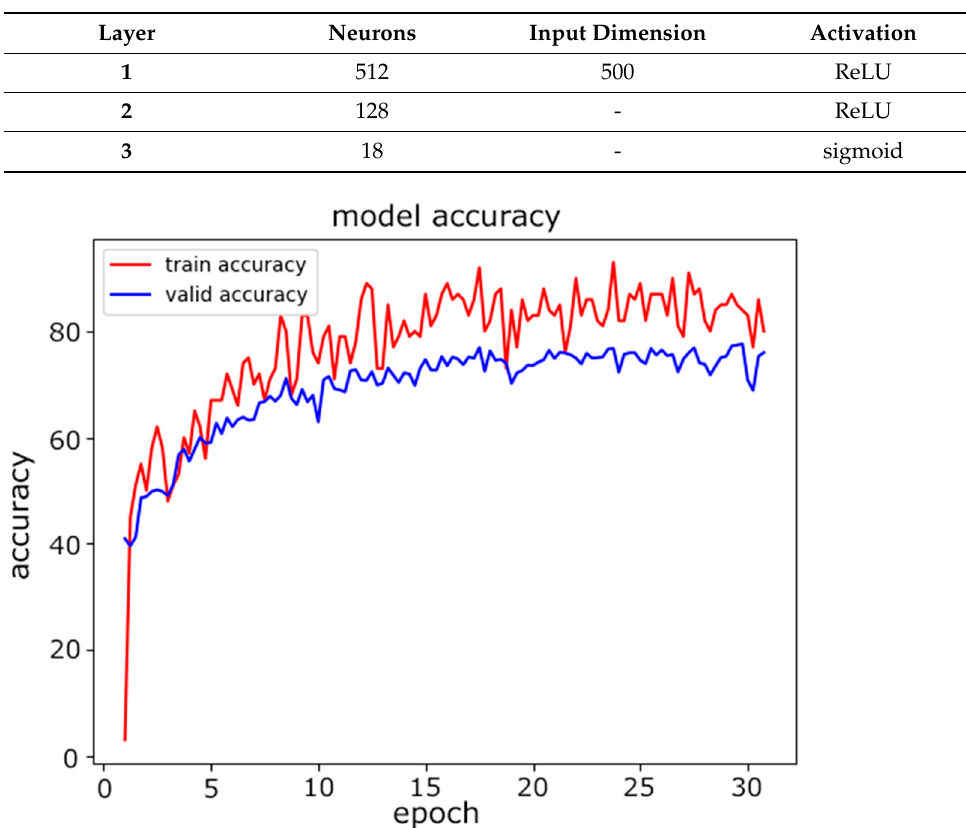
Figure 6. MLP model loss. Second, the proposed CNN model was tested on the same data. The dataset was again split at a ratio of 80%:10%:10% for the training, validation, and testing. Figure 7 shows the progress of training in terms of accuracy as the number of epochs increased. We selected the maximum number of epochs to be 30 to achieve the desired accuracy. Figure 8 illustrates how the loss was is reduced as the number of epochs increased. The loss we used during training was the cross-entropy loss. As the value of the loss decreased, the predictions improved.